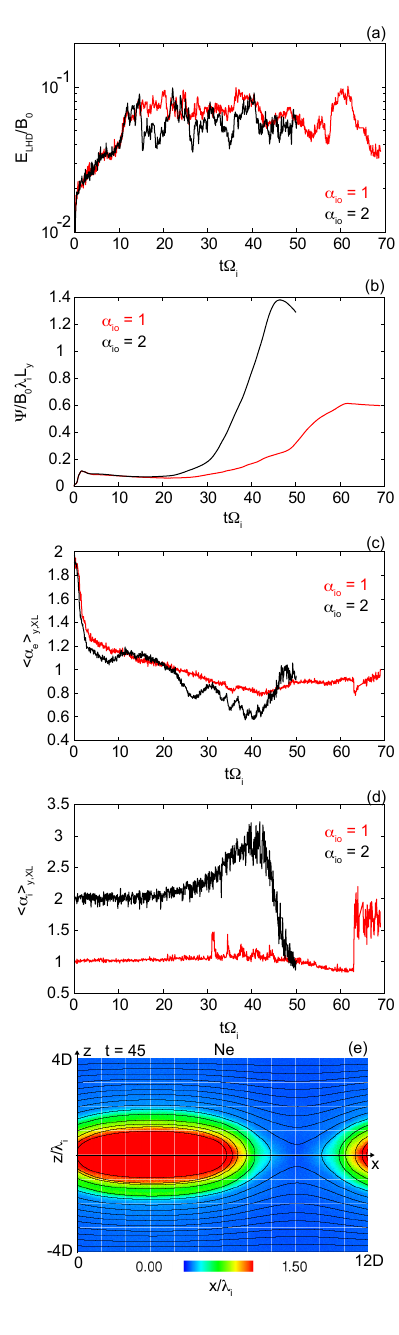
Fig. 4. Comparison between the α io =1 and the α io =2 cases with D =1.125 and α eo =2. The red (black) lines show the results of α io =1 (2) case, respectively. Temporal developments of (a) E LHD , (b) 9 , (c) <a e > y,XL , and (d) <α i > y,XL are shown. (e) 2-D XZ contour of plasma number density (color) and the field lines (black curve) at the saturation time of t =45 from the α io =2 case. With α io =2, the explosive reconnection saturates at t =45 with 9 =1.4, which is doubled compared to the α i =1 case. At the same time, 2-D XZ contour shows that field line reconnection fully across the current sheet is attained with the help from the ion anisotropy